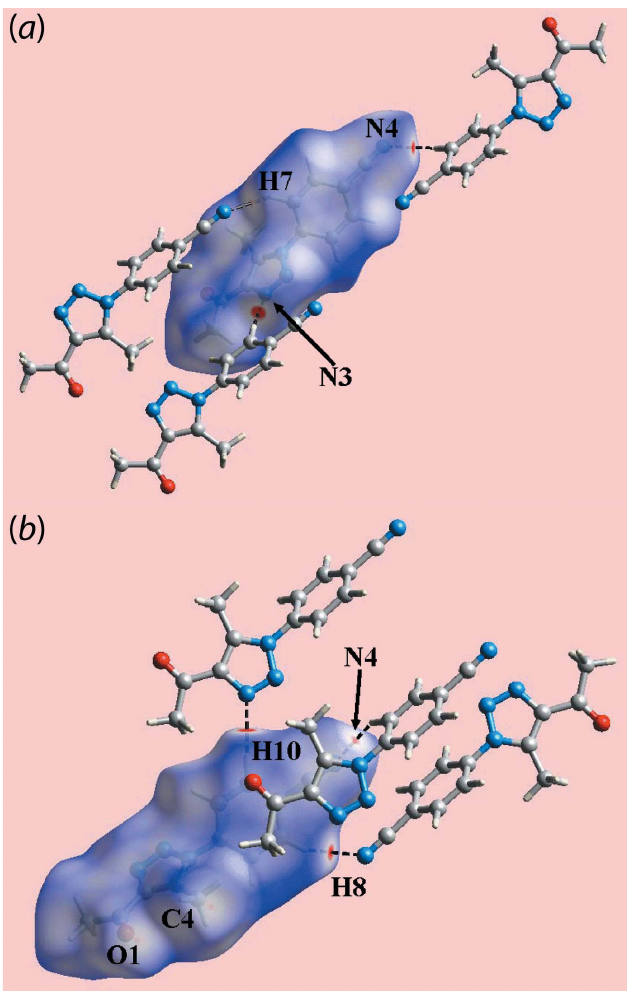
Figure 3 Two views of the Hirshfeld surface for (I) mapped over d norm in the range (cid:4) 0.065 to +1.215 a.u.